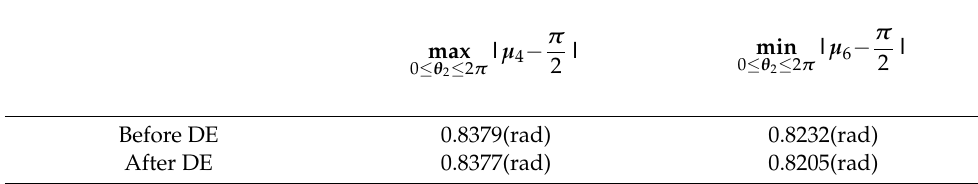
Table 3. The deviation of µ 4 and µ 6 respectively from π /2 before/after DE optimization.